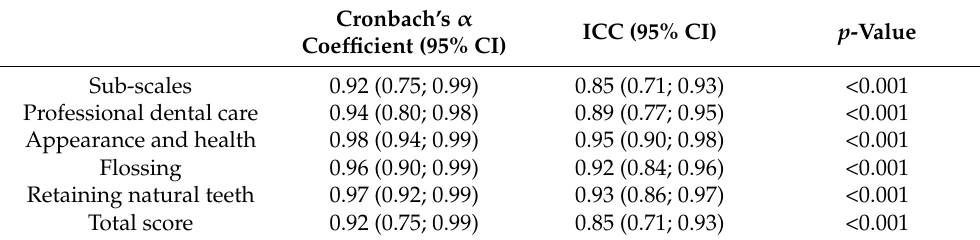
Table 2. Test–retest reliability using ICCs for the OHVS-PT questionnaire.